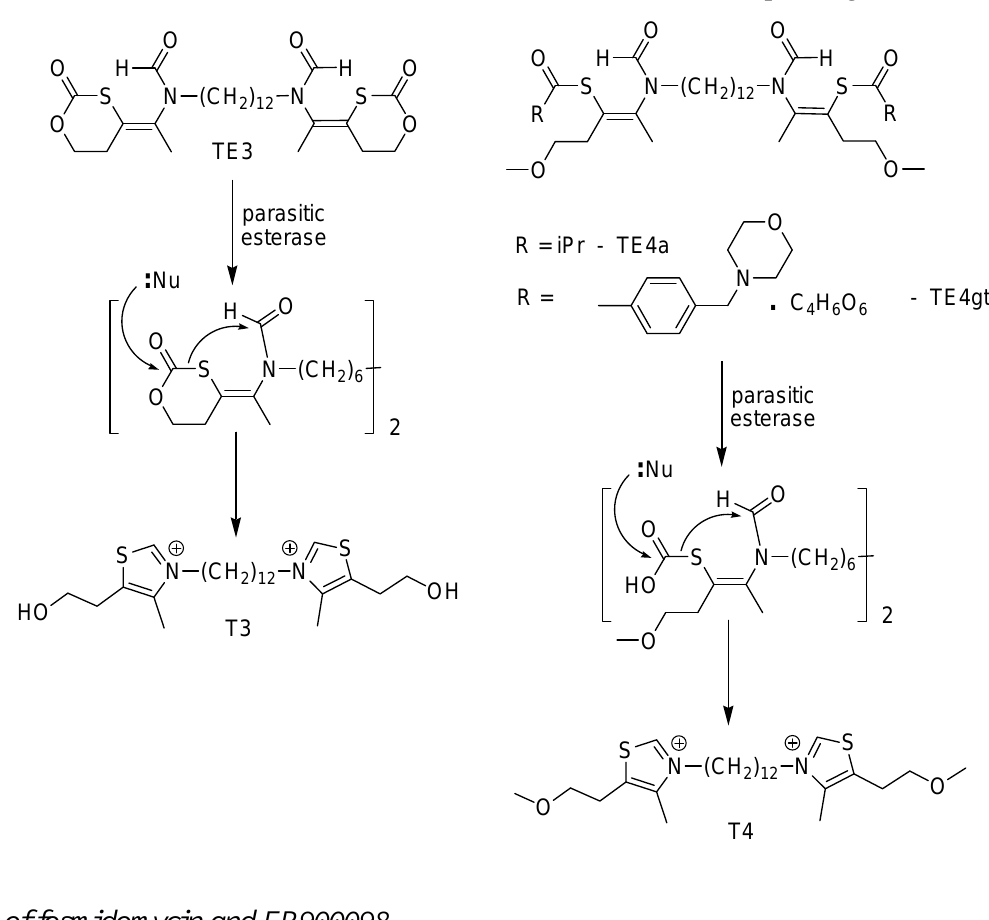
Figure 14. Chemical structures of bisthiazolium salt prodrugs.